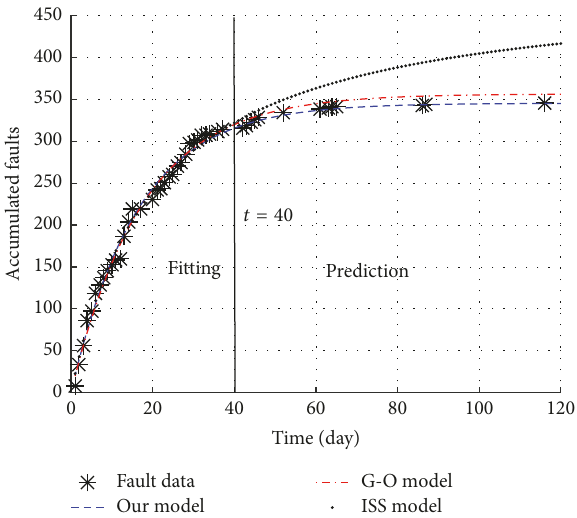
Figure 9: Fitted curves of three models for total accumulated